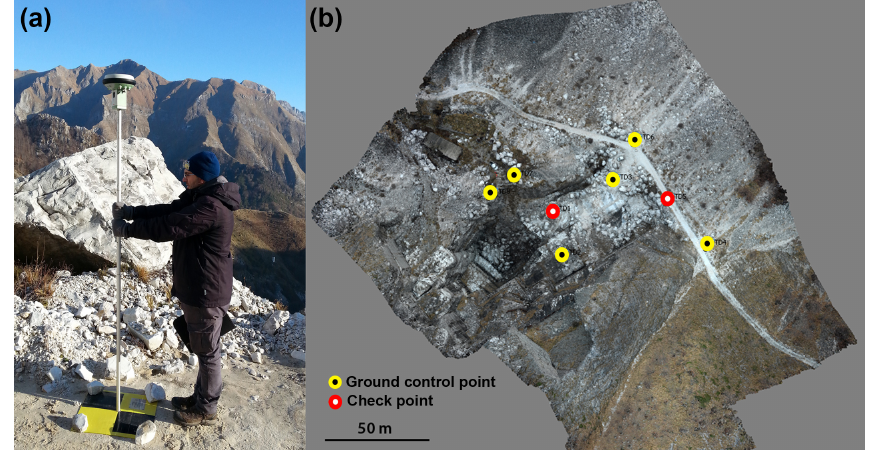
Figure 4. Example of a GCP measured during the RTK GNSS field survey (a) and spatial distribution of GCPs and check points for the RPAS zenithal flights (b)